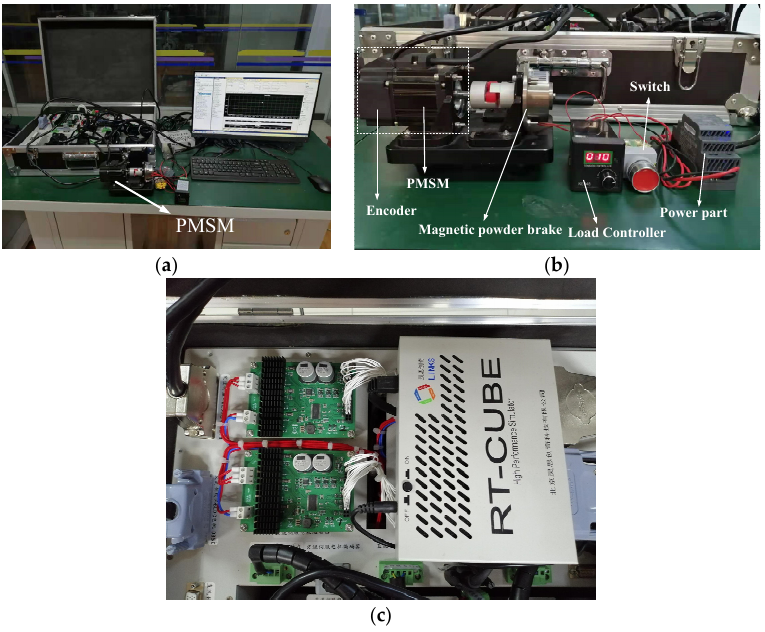
Figure 8. LINKS RS PMSM console: ( a ) servo control platform, ( b ) load system, and ( c ) controller and driver. Table 1. Parameters of the PMSM.